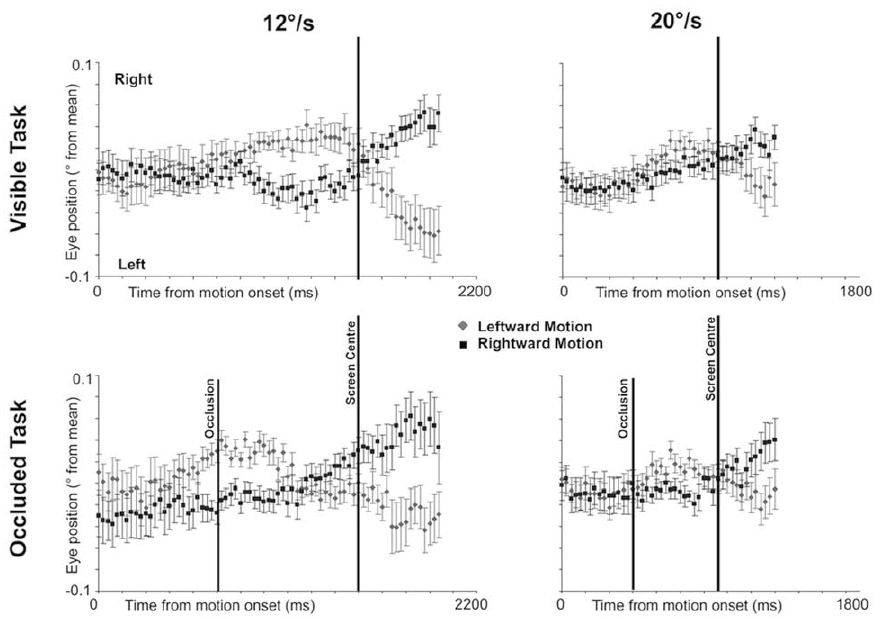
Figure 4. Fixational eye movements. Standardized eye position is shown as a function of time since target onset in the 12 and 20 u /s conditions of the Visible and Occluded Tasks. Error Bars = + / 2 1 S.E.M.